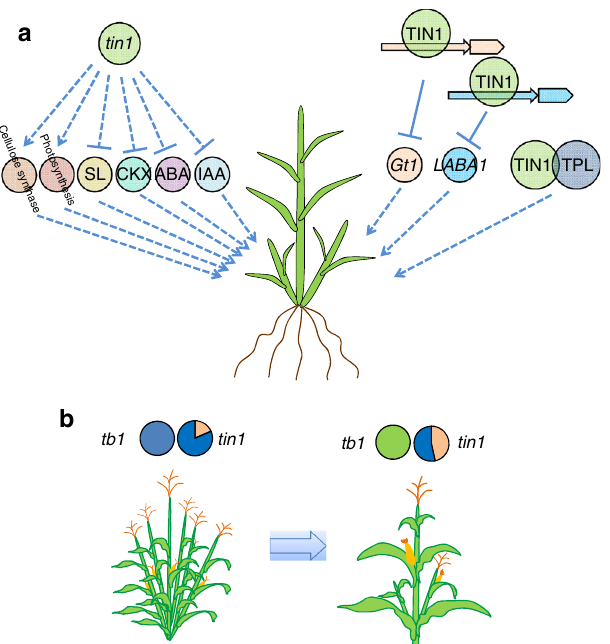
Fig. 7 Maize tin1 potential network and the path to tillering retention. a potential regulatory network mediated by tin1 . Dashed arrows represented indirect promotion of genes. Solid and dashed T bars signi fi ed direct and indirect repression of genes. b The path to maize tillering retention. Sweet maize and popcorn retained tillering by picking up the standing splice-site variant C/GT in tin1 , which originated from the wild progenitor, teosinte, after the key gene tb1 became fi xed in maize. The pie charts showed the percentage of causal variants in maize subgroups from two key genes, tin1 and tb1